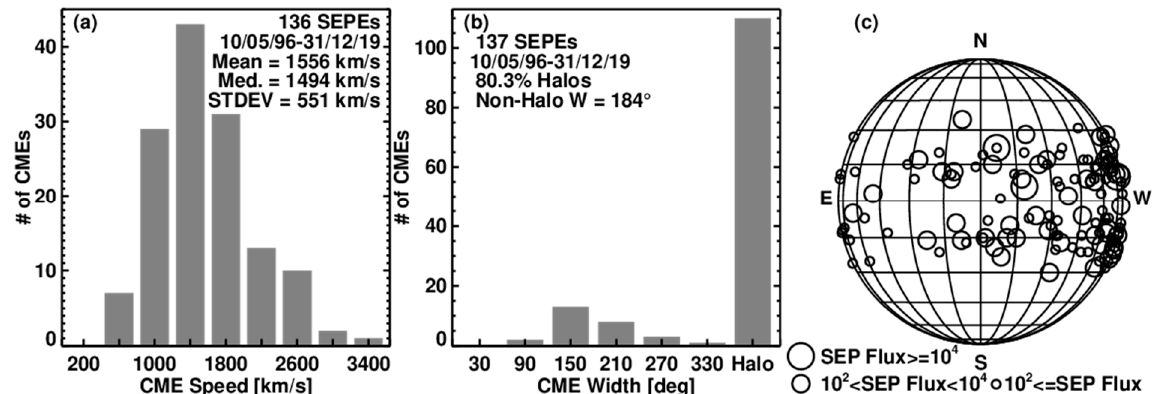
Figure 15. # means Number in Figure 15a,b. Same as Figure 13, but for CMEs associated with large SEP events: ( a ) speed, ( b ) width, and ( c ) source locations Three intensity levels of >10 MeV protons are distinguished by the size of the data points in ( c ). Table 2. CME speeds and SEP intensities of east-limb events observed by GOES and STB.